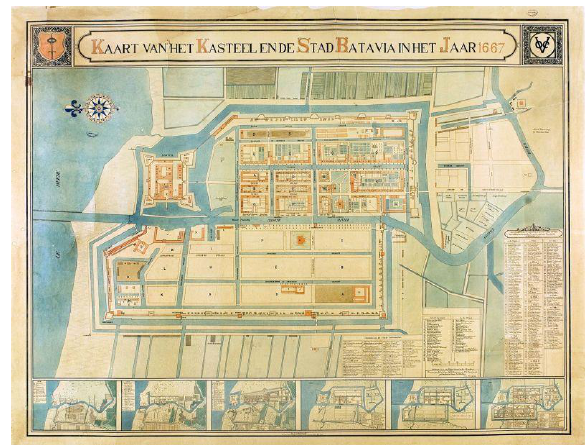
Figure 10. The development of Batavia based on the military defensive engineering stratagem by Simon Stevin. Tropenmuseum, part of the National Museum of World